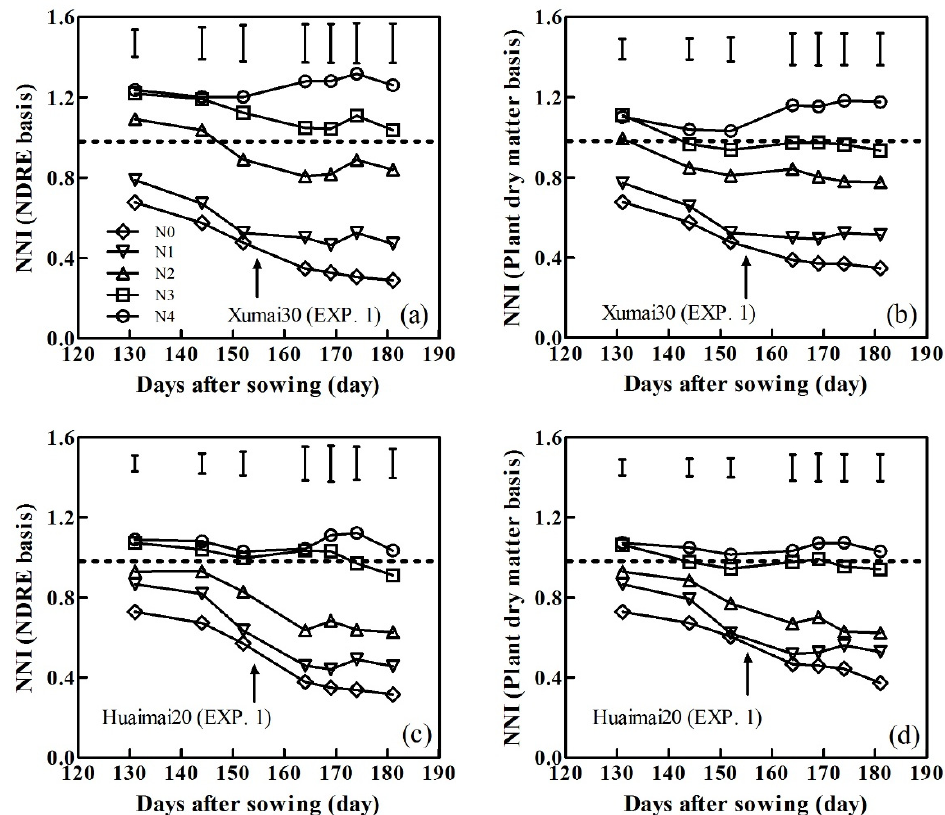
Figure 7. N nutrition index (NNI) calculated from the NDRE at di ff erent sampling dates for ‘Xumai30 (EXP. 1)’ ( a ) and ‘Huaimai20 (EXP. 1)’ ( c ). The NNI was calculated based on the PDM at di ff erent sampling dates for ‘Xumai30 (EXP. 1)’ ( b ) and ‘Huaimai20 (EXP. 1)’ ( d ). Arrows indicate the days of topdressing N application. Vertical bars at each sampling date represent the LSD values ( P ≤ 0.05).